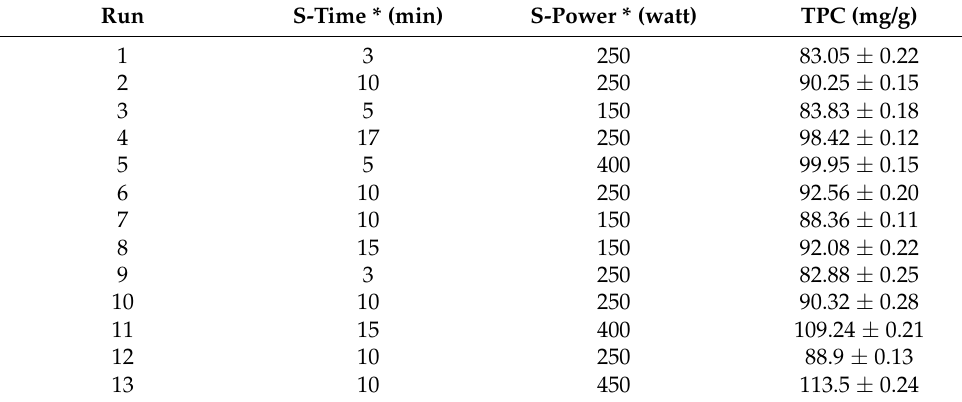
Table 1. The experimental design used and values of the